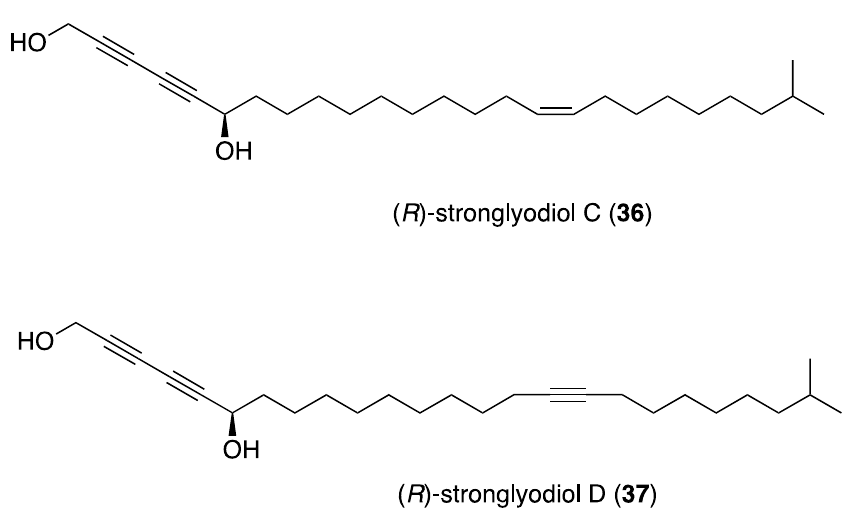
Figure 5. The structures of (R)-Strongylodiols C and D ( 36 and 37 , respectively). We also used the alkyne zipper reaction in our formal synthesis of volicitin ( 38 ) [79], see Scheme 25. In this synthesis, 1-octyne, treated with MeLi, is reacted with oxirane to give 3-decanyl-1-ol. This compound was treated with NaAPA to isomerize. Over a few reactions, including the coupling to the amino acid [80], the natural product volicitin was synthesized.